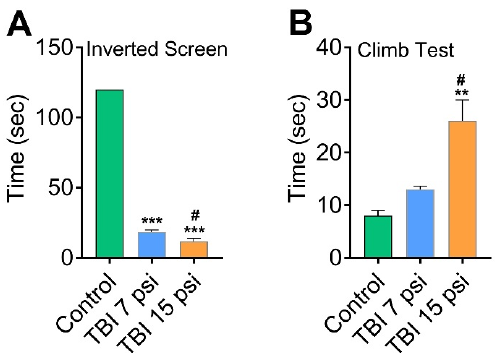
Figure 5. FPI causes deficits in motor skills and neuromuscular strength: ( A,B ). Inverted screen ( A ) and climb test ( B ) to access motor skills and neuromuscular strength demonstrated deficit in inverted screen test and climb test. Values are mean ± SEM; n = 6. ** p < 0.01, *** p < 0.001 versus uninjured control; # p < 0.05 versus 7 psi injury.